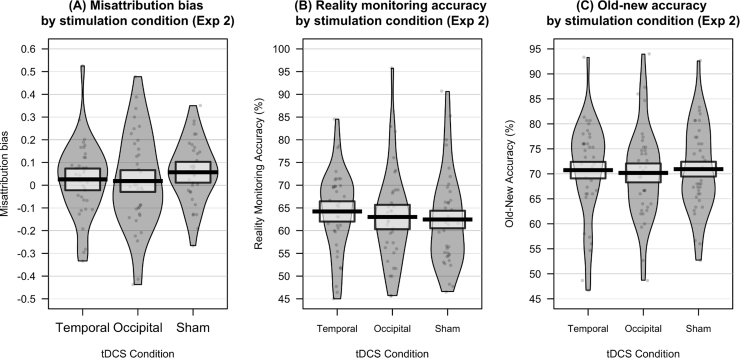
A: Misattribution bias: higher values correspond to a higher likelihood of external misattributions when errors are made. B: Reality monitoring accuracy: the percentage of trials on which participants made correct source judgements, for items correctly recalled as old. C: Old-new accuracy: the percentage of trials on which participants correctly classified items as old or new. Solid line = mean performance. Box = 95% confidence interval. Violin = smoothed density. Violin plots were generated in R, using the ‘yarrr’ package.